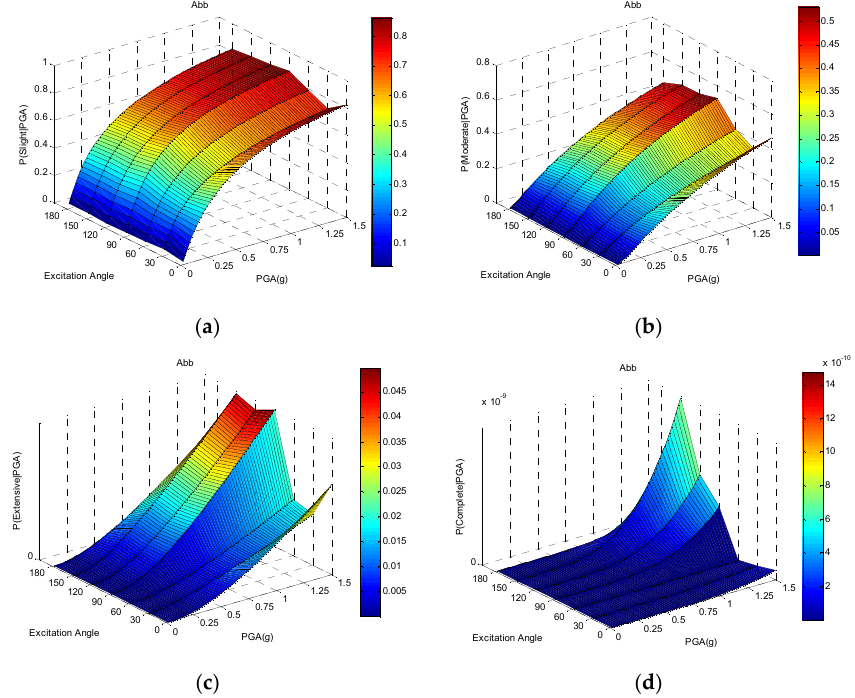
Figure A2. Seismic fragility surfaces of Abb subjected to different excitation angles in the ( a ) slight; ( b ) moderate; ( c ) extensive; and ( d ) complete limit states.